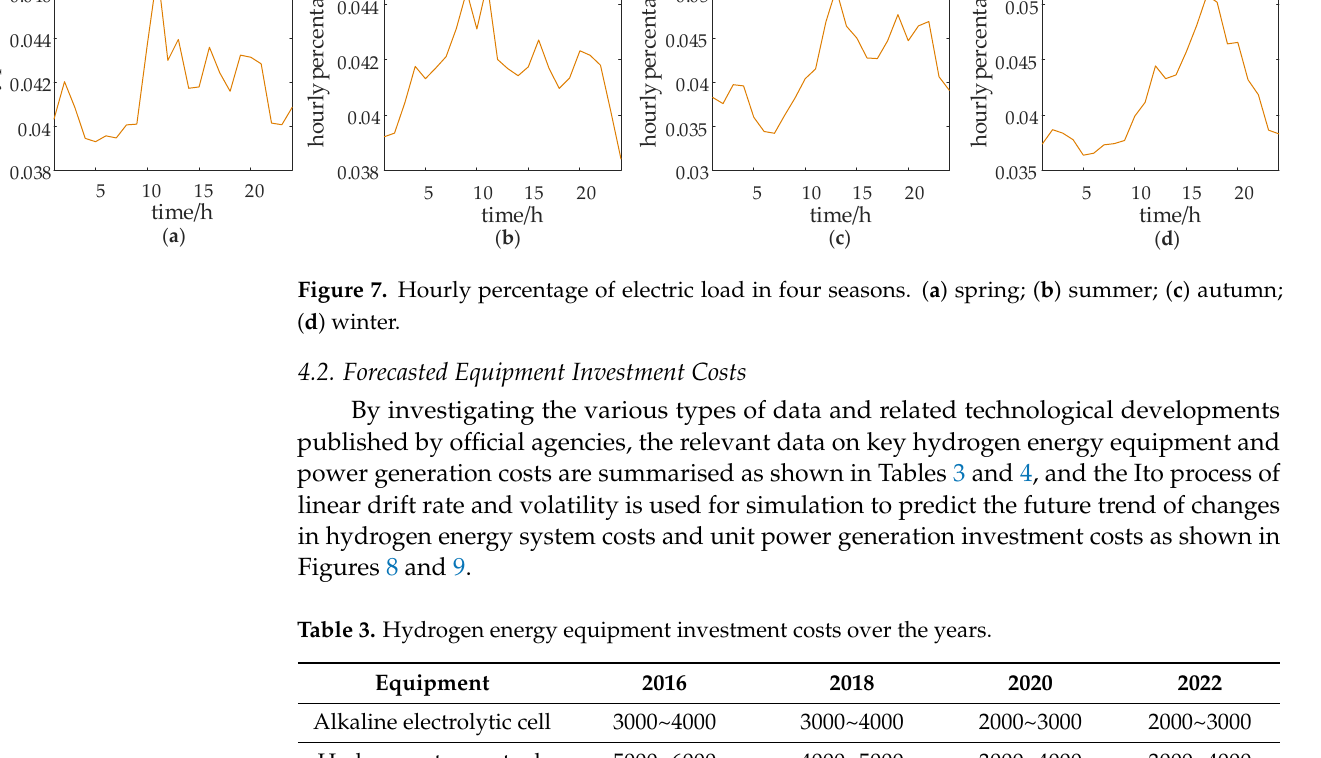
Table 4. Power generation equipment investment costs over the years.